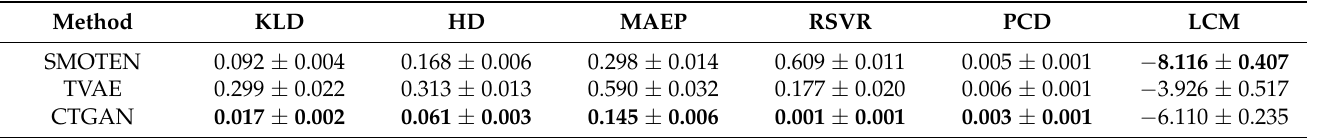
Table 2. Mean ± std (evaluated on 5 training partitions) of the data quality metrics for different oversampling techniques when considering IR = 1.0. The best values are shown in bold.